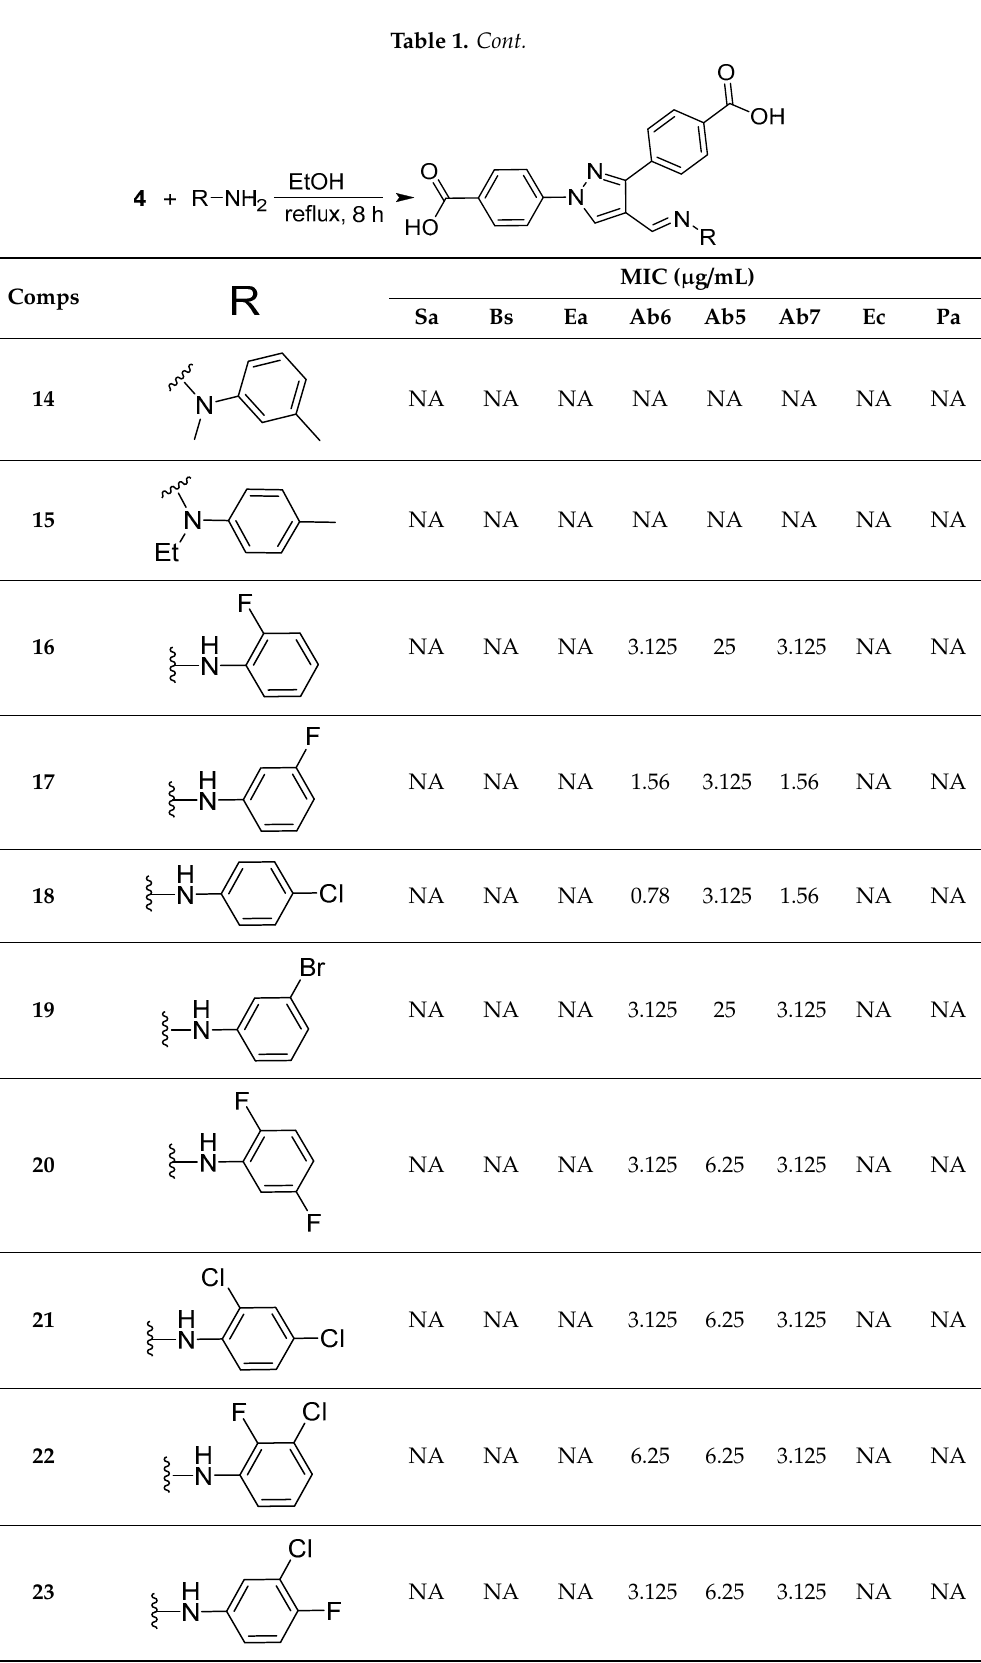
Table 1. Synthesis and antimicrobial activity of (pyrazole-1,3-diyl)dibenzoic acid substituted hydrazone derivatives.